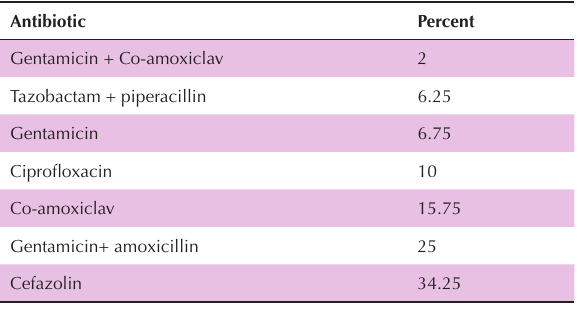
Table 1. Type of antibiotic used as prophylactic antibiotics